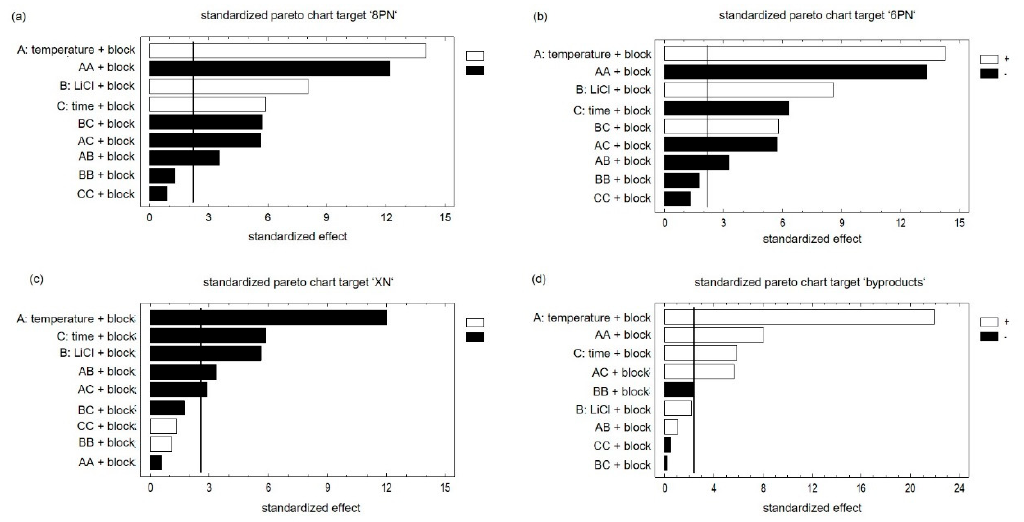
Figure 4. Pareto charts of all targets ‘8PN’ ( a ), ‘6PN’( b ), ‘XN’( c ) and byproducts ( d ) with a significance level of 5% concerning the factors ‘temperature’‚ ‘lithium chloride’, and ‘time’ as well as the ‘block factor’, which has to be considered due to the duration of the experiment.